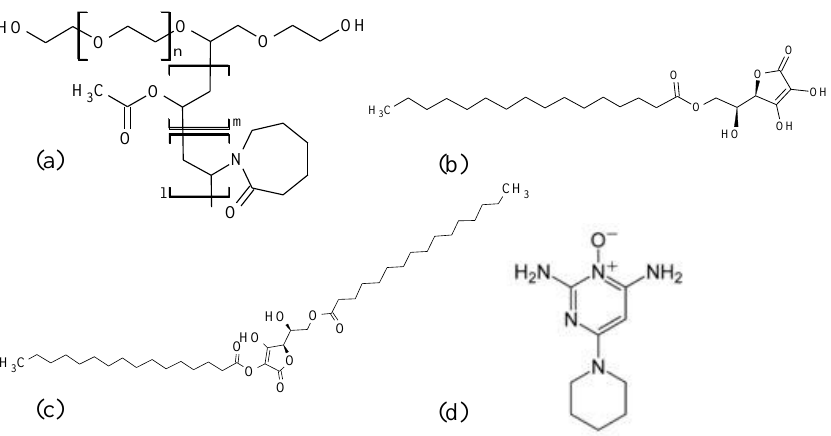
Figure 1. Chemical structures of ( a ) Sol, ( b ) ASC-P, ( c ) ASC-DP, and ( d ) minoxidil.